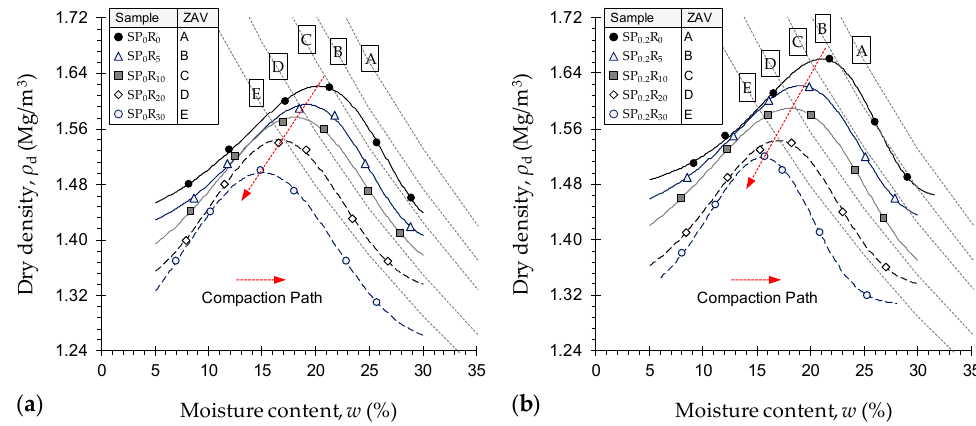
Figure 6. Standard Proctor compaction curves for the natural soil and various GR-blended samples: ( a ) Untreated— SP 0 R y where y = {0, 5, 10, 20, 30}; and ( b ) Treated with 0.2 g / L PAM— SP 0.2 R y where y = {0, 5, 10, 20, 30}.